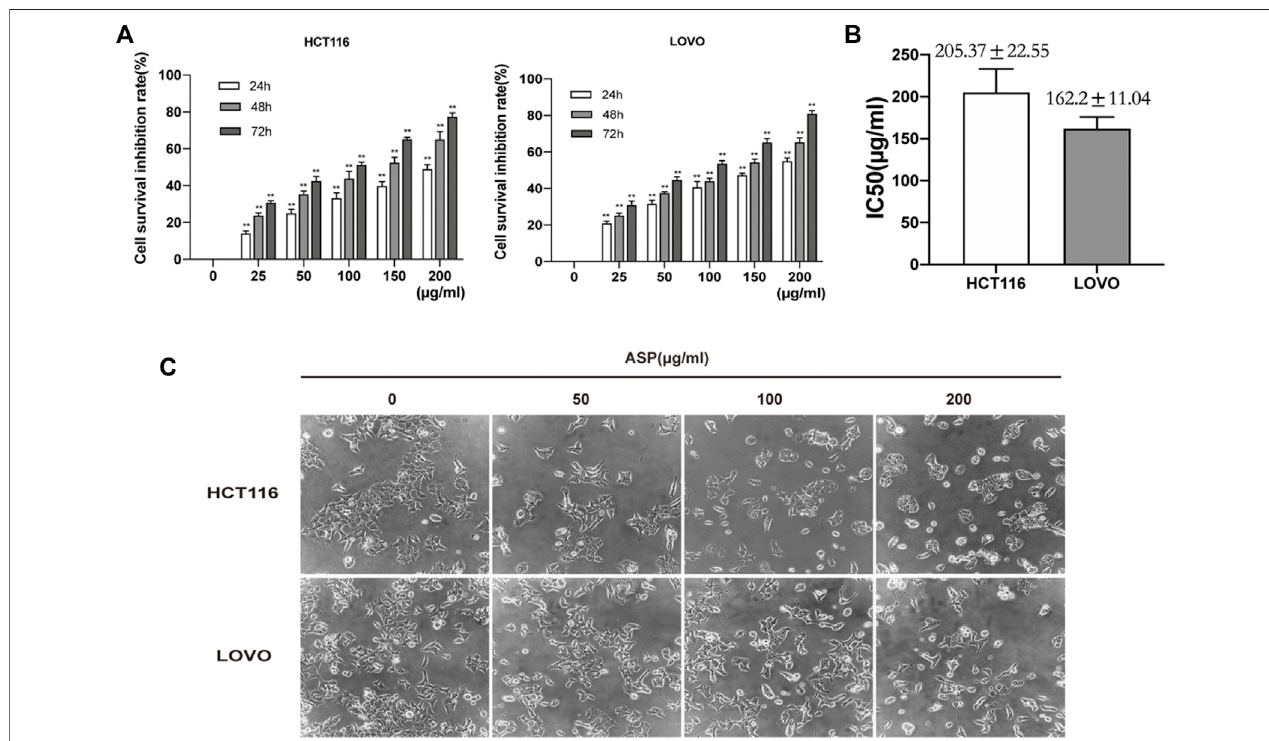
FIGURE 4 | Asparagus aqueous extract (ASP) inhibits the proliferation of HCT116 and LOVO cells. (A) Cell Counting Kit-8 (CCK-8) analysis of human colorectal cancer(CRC)celllines(HCT116andLOVOcells)aftertreatmentwiththeindicateddosesofASPfor24,48,and72 h. (B) Medianinhibitoryconcentrations(IC50)ofASP acting against HCT116 and LOVO cells for 24 h. (C) Morphological changes of cells observed by light microscopy after 24 h of ASP application at the indicated concentrations. * p < 0.05, ** p < 0.01 vs .